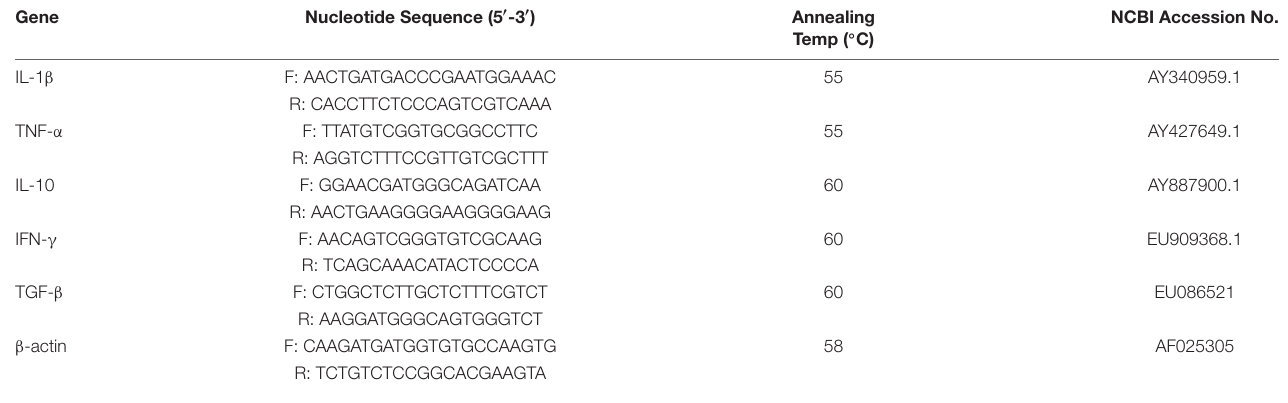
TABLE 2 | Sequences and conditions of the primers used in RT-PCR analysis. Gene Nucleotide Sequence (5 (cid:48) -3 (cid:48)